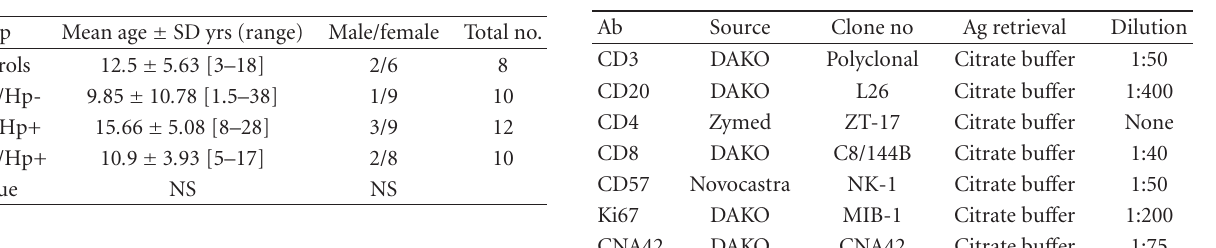
Table 1: Demographic data. Table 2: Antibodies used for immunohistochemical